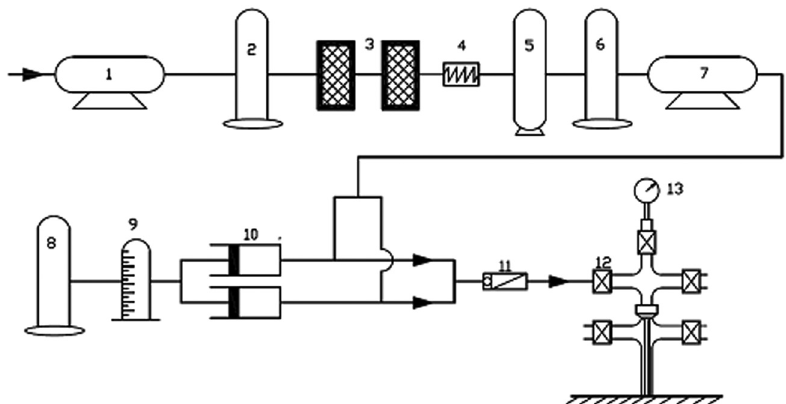
Figure 9: Steam - foam pro fi le modi fi cation operation fl ow chart. ( 1 ) Air compressor; ( 2 ) air bu ff er tank; ( 3 ) fi lter; ( 4 ) heater; ( 5 ) N 2 generator; ( 6 ) N ff er tank; ( 7 ) N ( 8 ) foaming agent storage tank; ( 9 ) calibration tank; ( 10 ) double plunger metering pump; ( 11 ) foam 2 bu 2 booster; generator; ( 12 ) check valve; ( 13 ) pressure